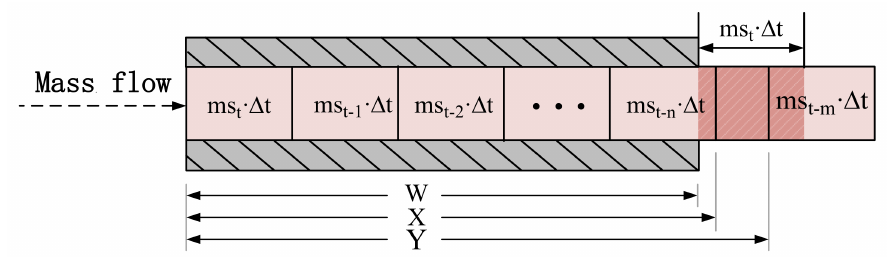
Figure 8. Illustration of the node